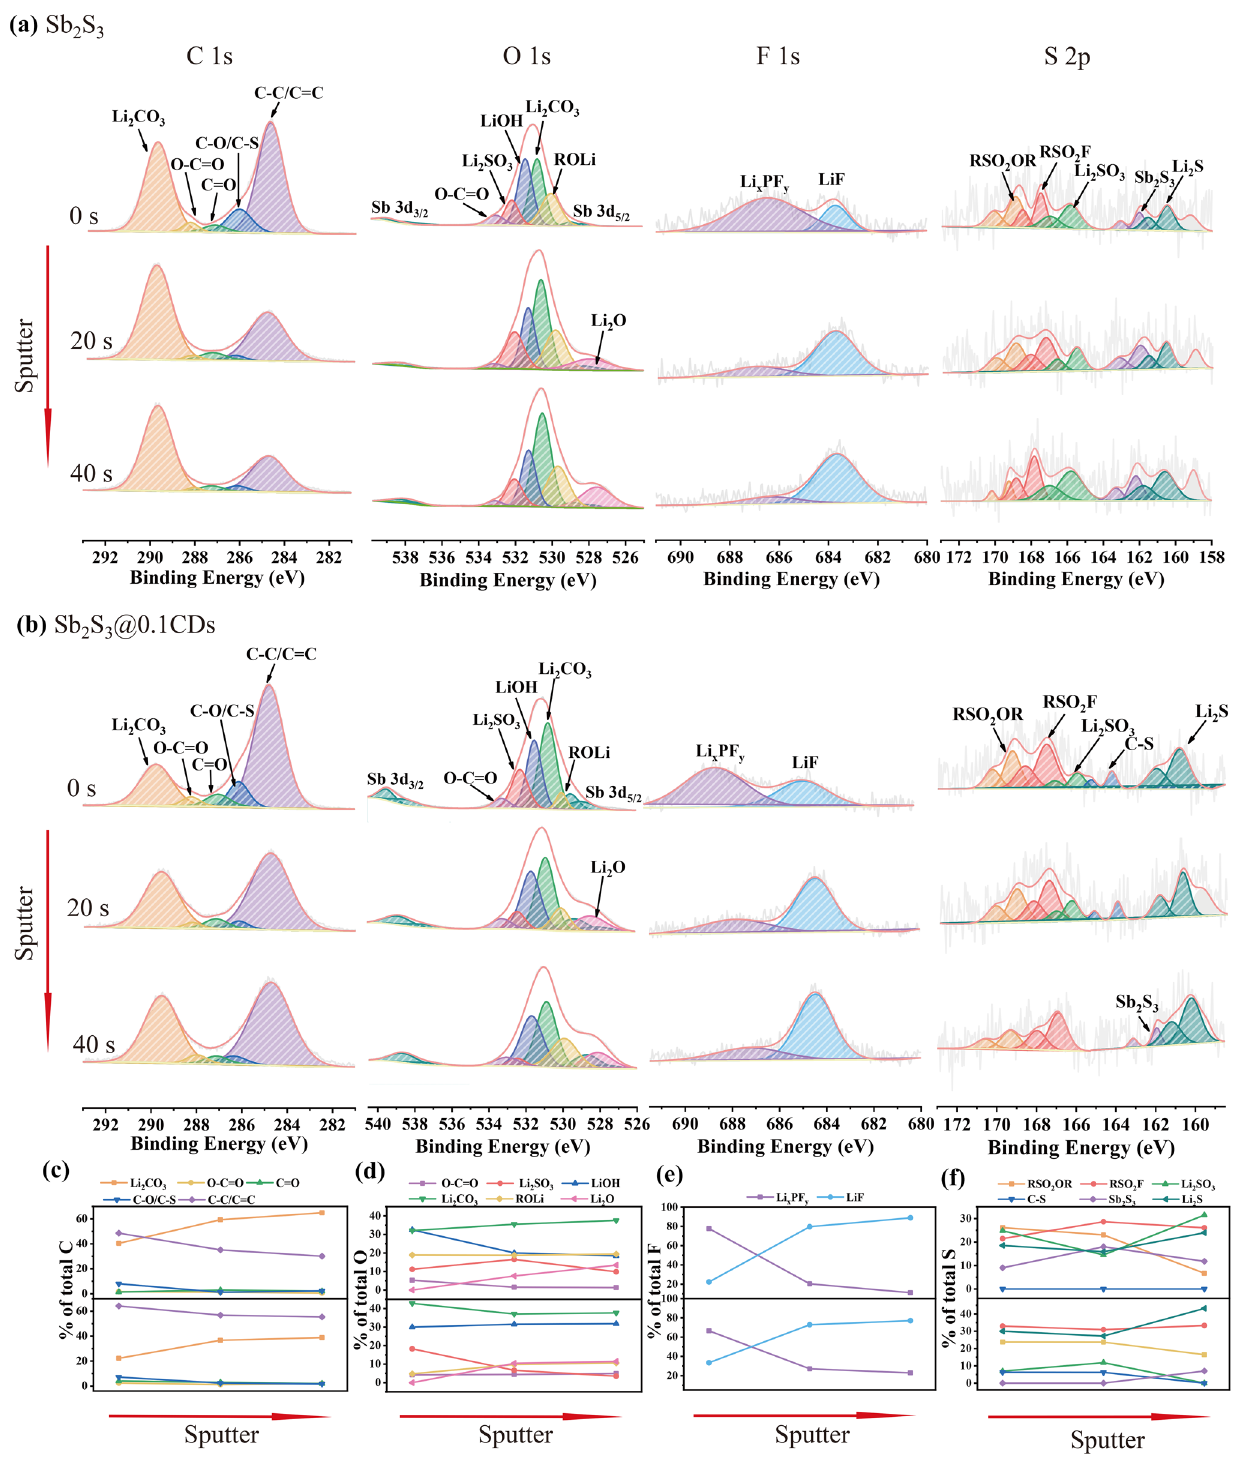
Fig. 8 High-resolution XPS spectrum of a stibnite Sb 2 S 3 and b Sb 2 S 3 @0.1CDs with sputtering time for 0, 20, and 40 s, respectively, and the corresponding proportions of primary existence forms of c C, d O, e F and f S elements. All states are discharging to 0.01 V in the first